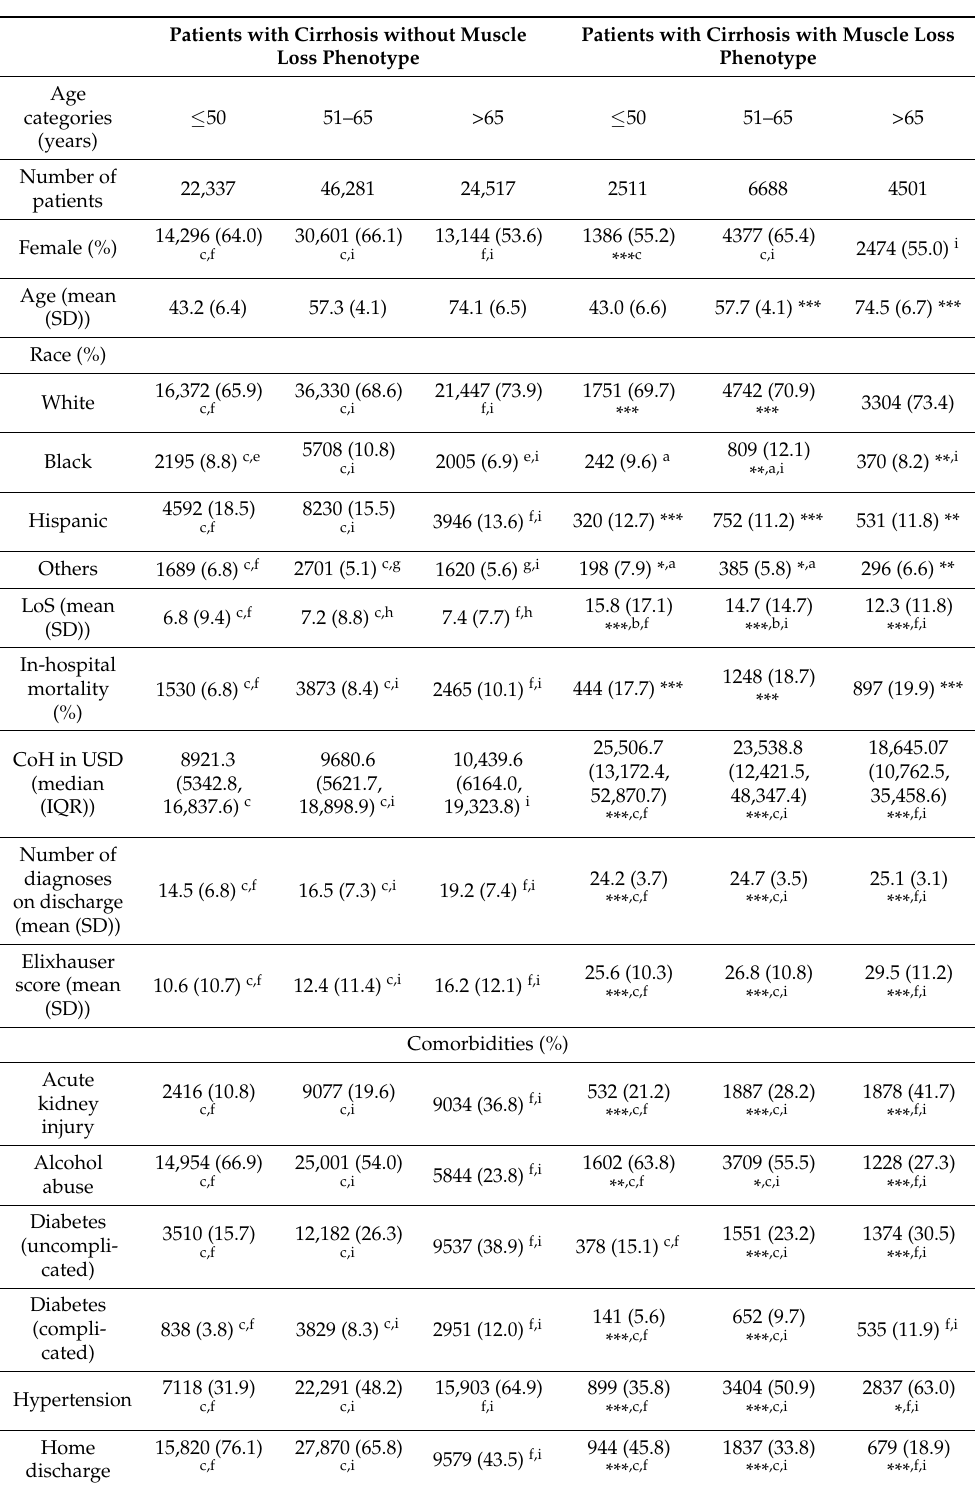
Table 5. Demographic characteristics of hospitalized patients with cirrhosis with/without muscle loss phenotype, grouped by